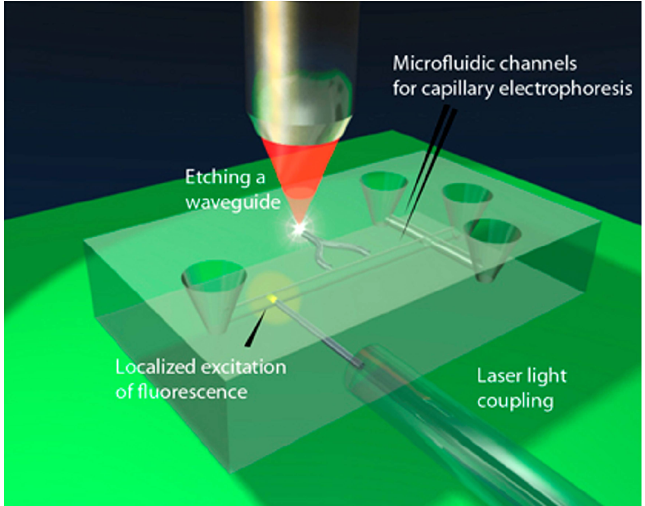
Figure 5. A schematic representation of an LOC device designed for capillary electrophoresis fabricated with a femtosecond-laser. The fluorescence is excited in a highly localised region in the microchannel by the optical waveguides and optical fibres. Moreover, the waveguides guide emissions to a detector. Reprinted with permission from [76]. Copyright 2014,